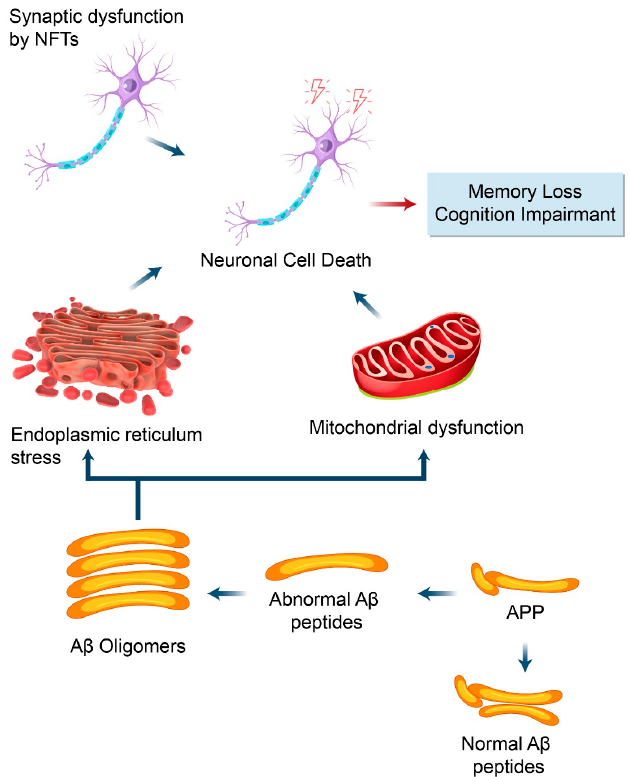
Figure 4. Schematic representing modulation of AD pathogenesis by APP. AD pathogenesis is initiated upon the accumulation of abnormal A β peptides ((1-42 A β peptide of 36–43 amino acids) derived from APP proteolytic cleavage through γ -secretase and β -secretase. A β oligomers stimulate ER stress and trigger mitochondrial dysfunction (generally produce ROS) which lead to cause neuronal death and impairment cognition function during AD progression. In addition, synaptic dysfunctions are also initiated due to hyperphosphorylation of tau which leads to the formation of neurofibrillary tangles (NFTs) which causes synaptic dysfunction and neuronal loss in AD pathogenesis.